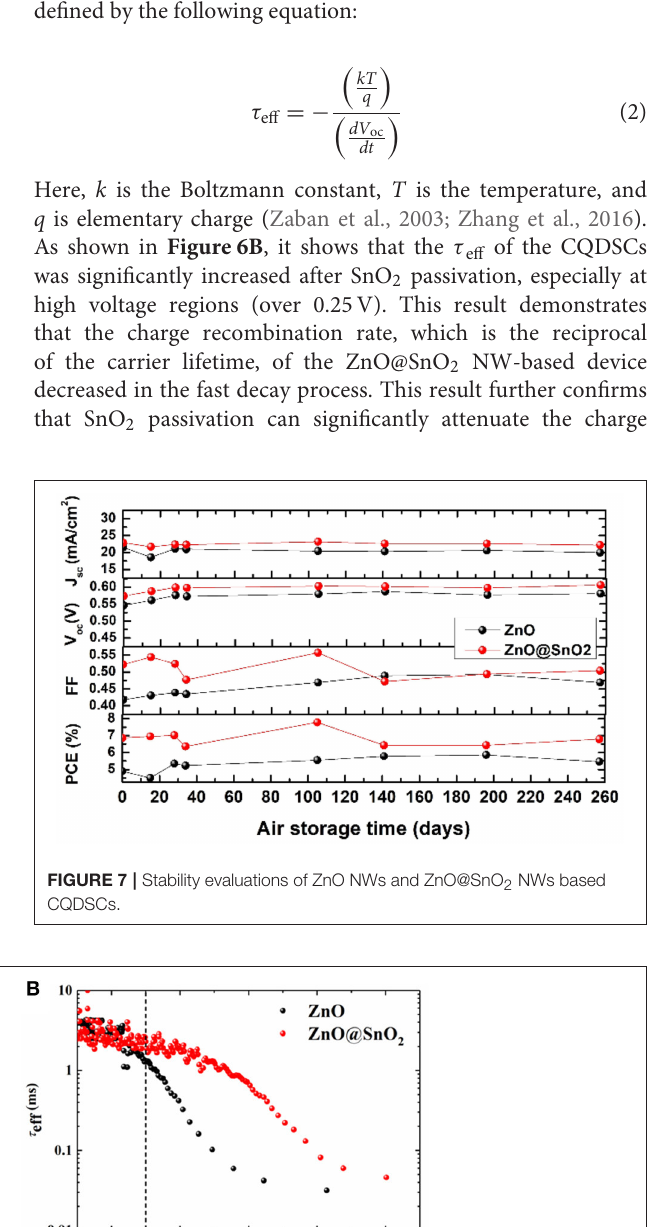
Frontiers in Energy Research |